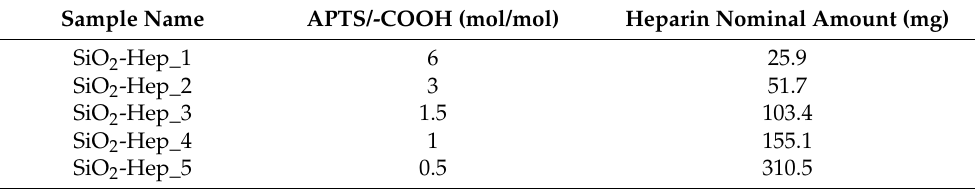
Table 1. APTS/-COOH group molar ratio and nominal amount of heparin used during synthesis. Sample